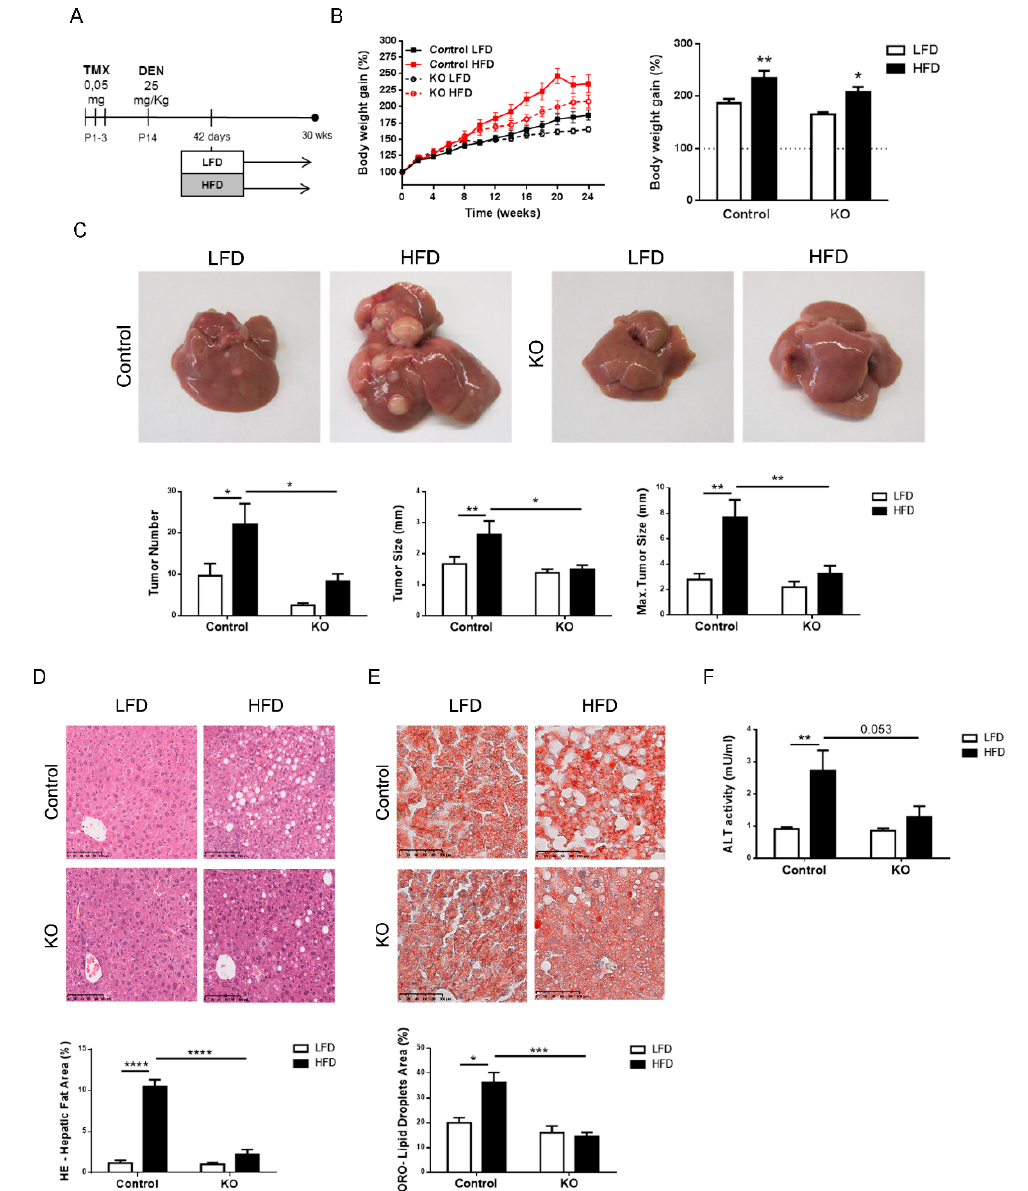
Figure 2. ARMCX3 deletion decreases diethylnitrosamine (DEN) ‐ induced tumorigenesis and steatohepatitis in mice exposed to HFD. Data were obtained from 7 ‐ month ‐ old f Armcx3/Cre ‐ (Control) or ARMCX3 ‐ KO mice (KO) treated with DEN and maintained on LFD or HFD. ( A ) Schematic representation of the study design: 15 ‐ day ‐ old f Armcx3/Cre ‐ (Control) and ARMCX3 ‐ KO mice were injected with 25 mg/kg DEN and, beginning at week 6, fed LFD or HFD for 24 weeks. ( B ) Body weight curves (left) and body weight gain (right). ( C ) Representative pictures of livers (top) and quantifications of tumor number, size and maximal tumor size (bottom). Representative images and lipid accumulation quantification in liver sections stained with hematoxylin ‐ eosin ( D ) and Oil ‐ Red O ( E ). Scale bar: 100 μ m. ( F ) Serum ALT levels. Bars show means ± SEM; n = 9–13 mice per group. Two ‐ Way ANOVA test with Tukey post hoc correction was used. * p ≤ 0.05, ** p ≤ 0.01, *** p ≤ 0.001 and **** p ≤ 0.0001 for comparisons between diets or treatments.